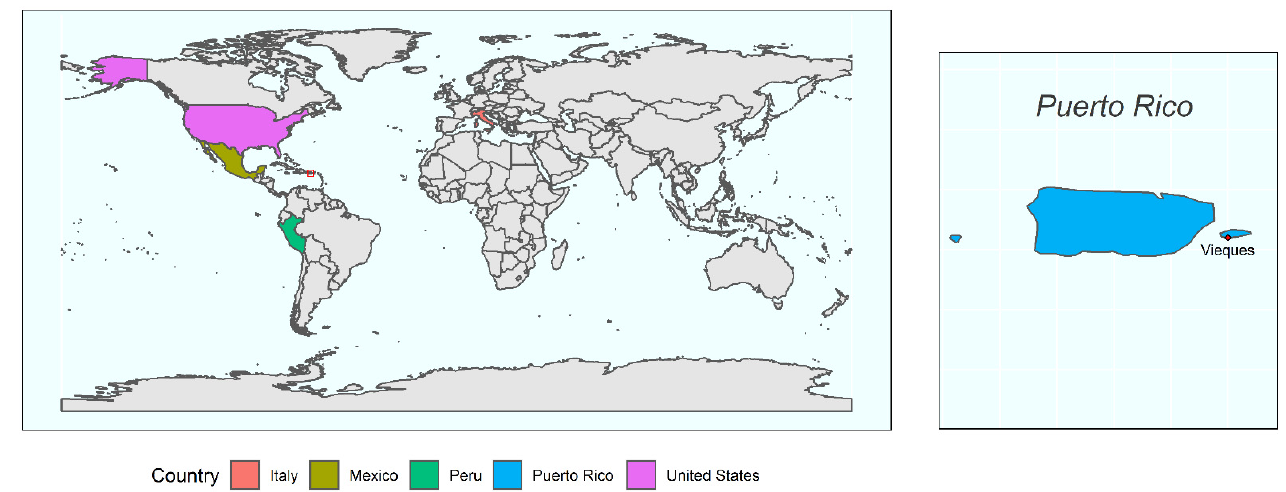
Figure 1. Geographic locations of the groups included in the present study. Puerto Rico is located between North and South America and is highlighted with a red square. Puerto Rico is magnified on the right side to show the municipality of Vieques, where coprolite samples were recovered.